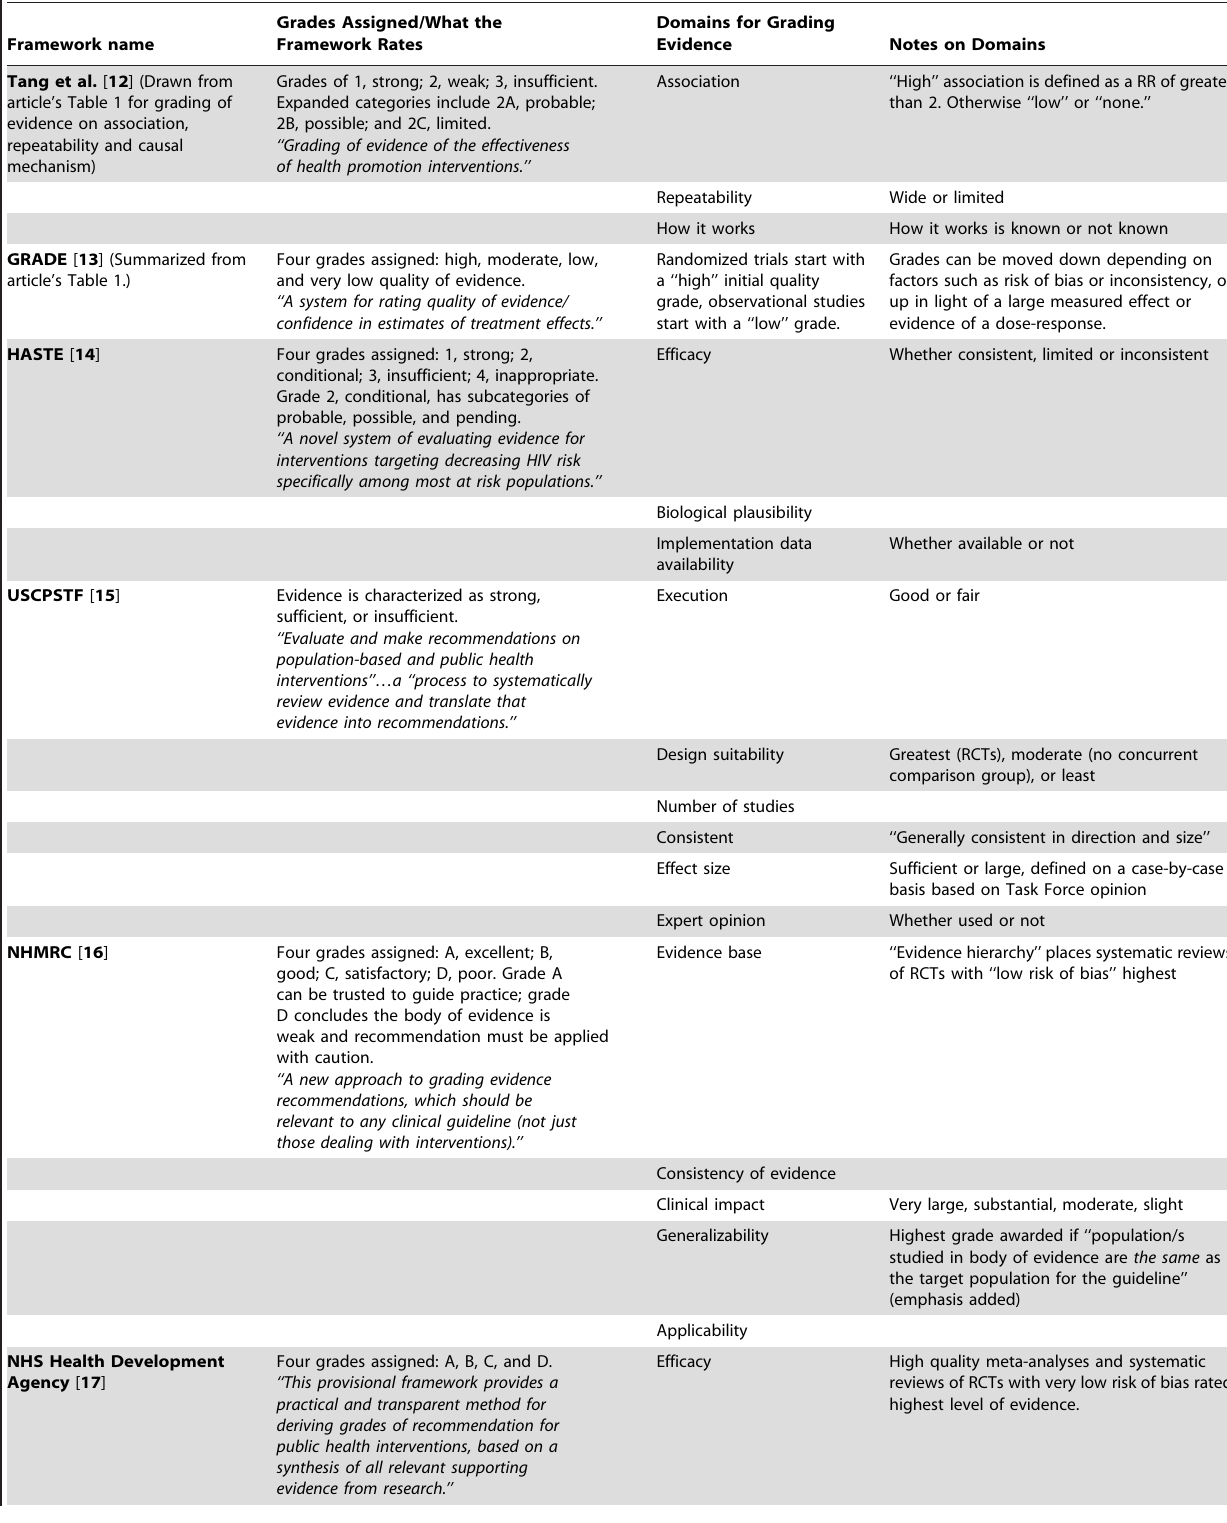
Table 1. Summary of existing public health frameworks